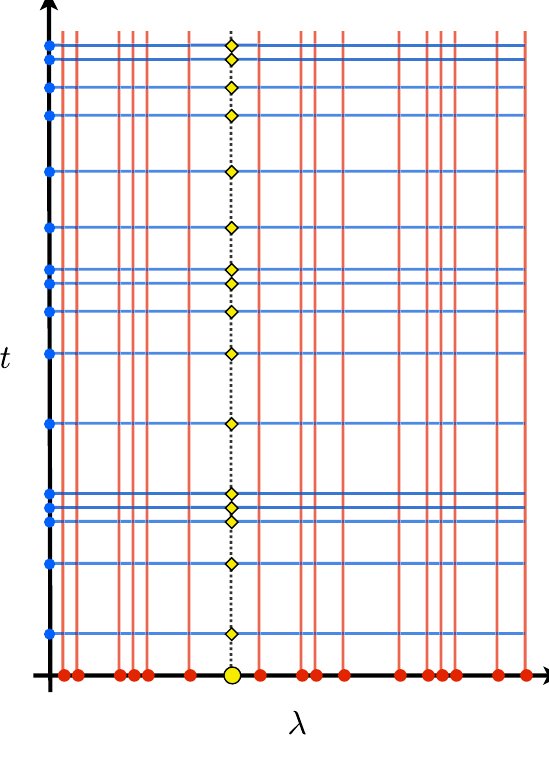
FIG. 1. A schematic of the method for building and evaluating the surrogate model. The red dots show the greedy selection of parameter points for building the reduced basis (step 1, offline), the blue dots (step 2, offline) show the associated empirical nodes in time from which a waveform can be reconstructed by interpolation with high accuracy, and the blue lines (step 3, offline) indicate a fit for the waveform ’ s parametric dependence at each empirical time. The yellow dot shows a generic parameter, which is predicted at the yellow diamonds and filled in between for arbitrary times using the empirical interpolant, represented as a dotted black line (step 4,